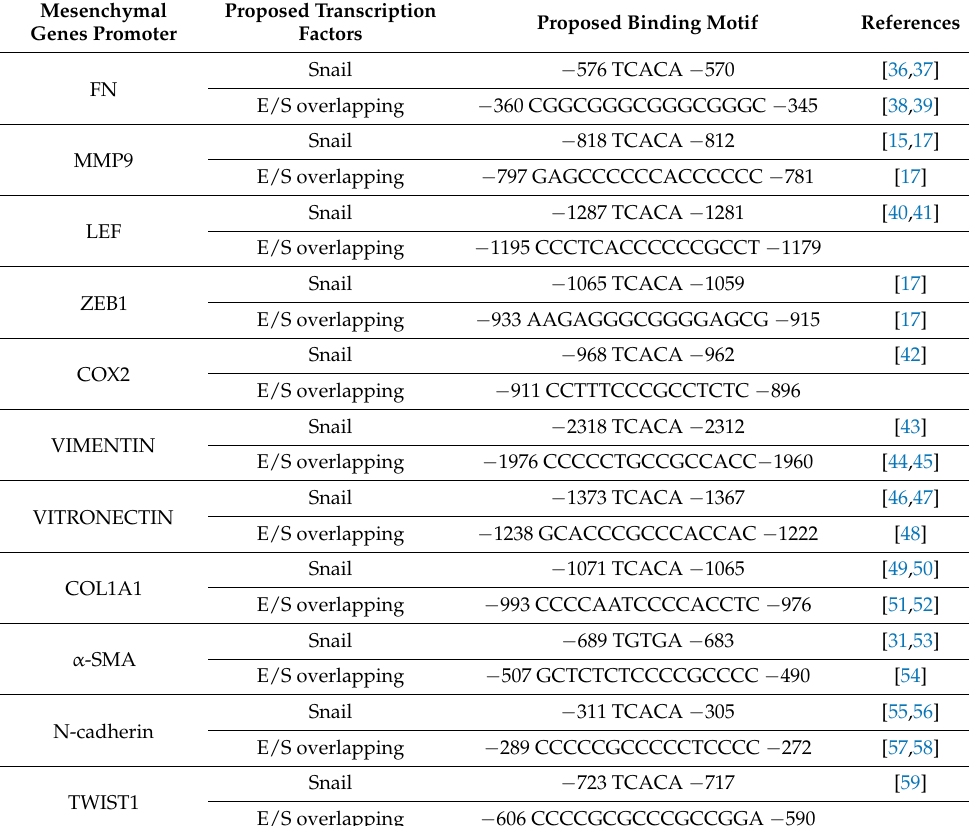
Table 4. Transcriptional factor binding region on candidate Mesenchymal genes.